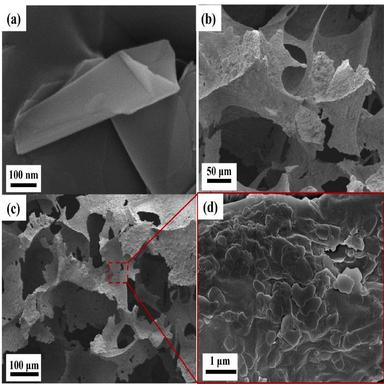
The SEM images of (a) exfoliation of h-BN; (b–c) BNCA porous structure; (d) high magnification of BNCA.